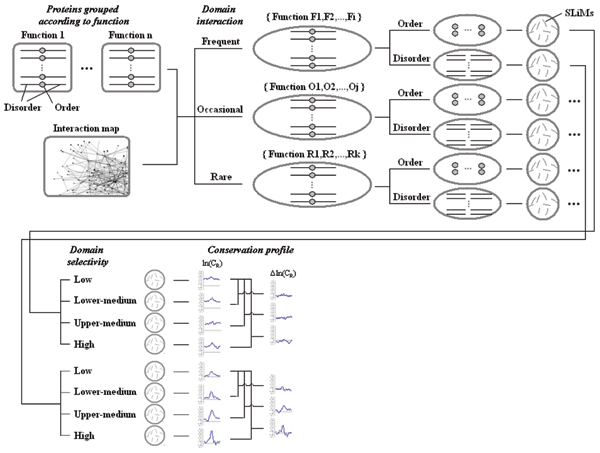
Schematic of the comparion among conservation profiles of SLiMs. For a particular domain that are under study, proteins are first grouped according to their molecular functions then further grouped into three categories according to the involvement of interaction with that domain (frequent, occasional or rare). In each of the categories obtained from the last step, proteins sequences are sorted into ordered and disordered regions. We then get the SLiMs in the protein regions and further grouped them into low, lower medium, upper medium and high domain selectivities. Conservation profiles are calculated for SLiMs in each group. The final output is the difference of ln(CR) value between SLiM that with medium, upper medium and high selectivity value and that with low selectivity value.